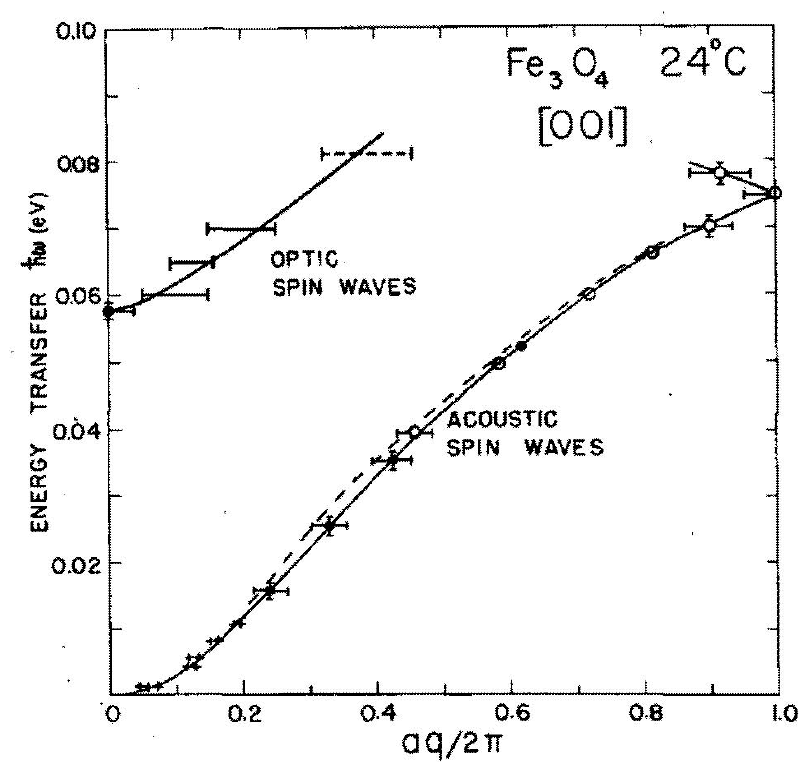
Figure 46. Experimental dispersion curves for magnetite, Fe 3 O 4 , at 297 K. The dashed curve gives the results prior to correcting for vertical divergence. Closed circles show results from constant- Q measurements, and open circles denote constant- υ measurements. This figure is taken from Figure 1 of ref. [79] courtesy of the IAEA.